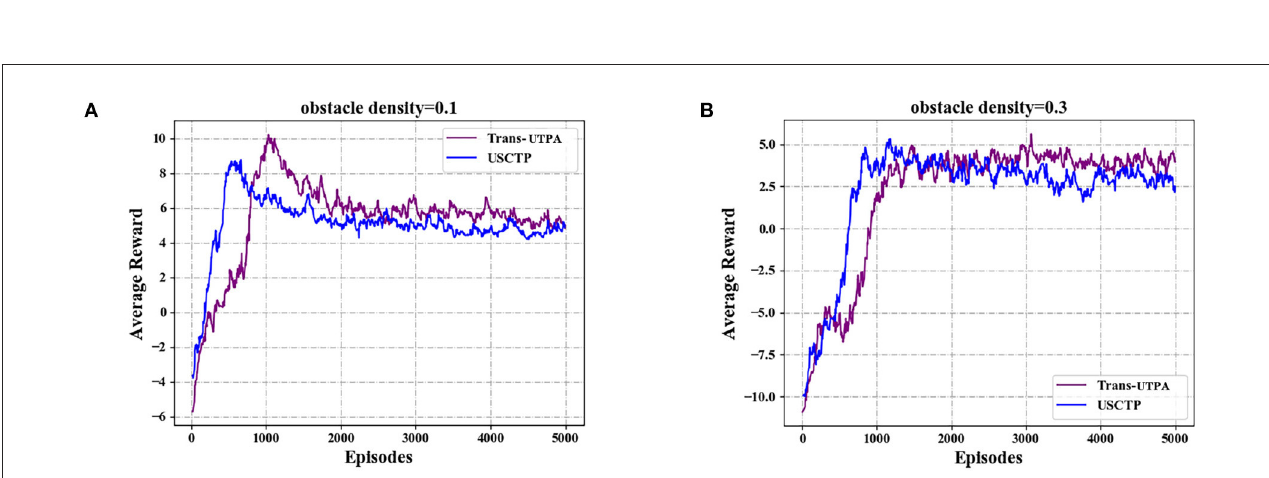
FIGURE11 Comparison experiment of the average rewards. (A) Average rewards with obstacle density = 0.1. (B) Average rewards with obstacle density = 0.3.